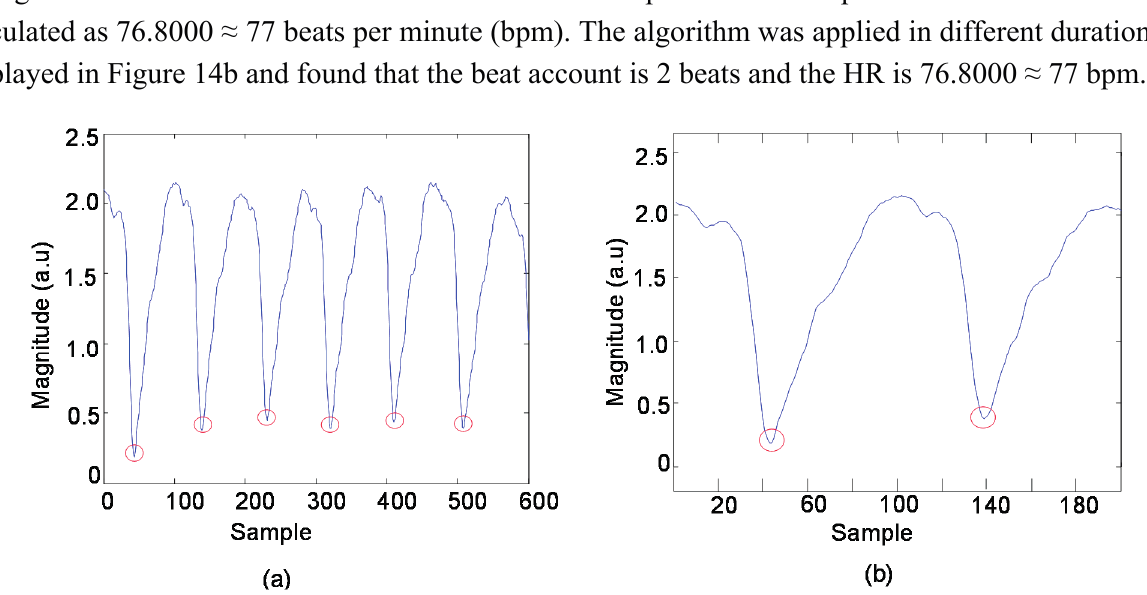
Figure 14. Inter beats count and average heart rate (HR) measurements from the pulsatile features of PPG signal. ( a ) Duration of 600 samples was detected as 6 beats count with 77bpm; ( b ) Duration of 180 samples was counted 2 beats with